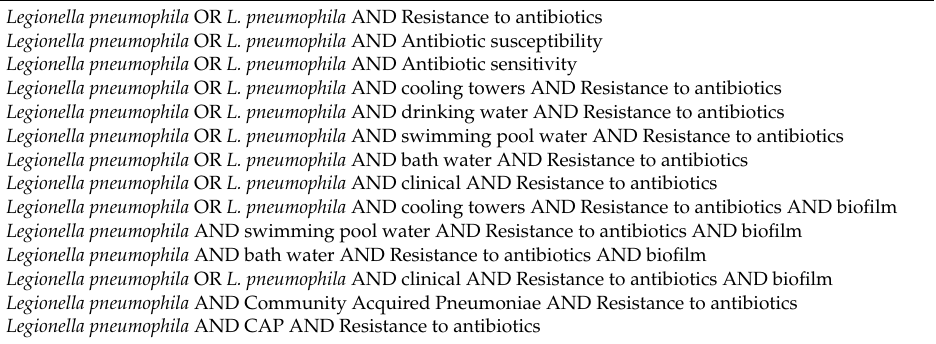
Table 1. The key terms and their variations in combination using Boolean search